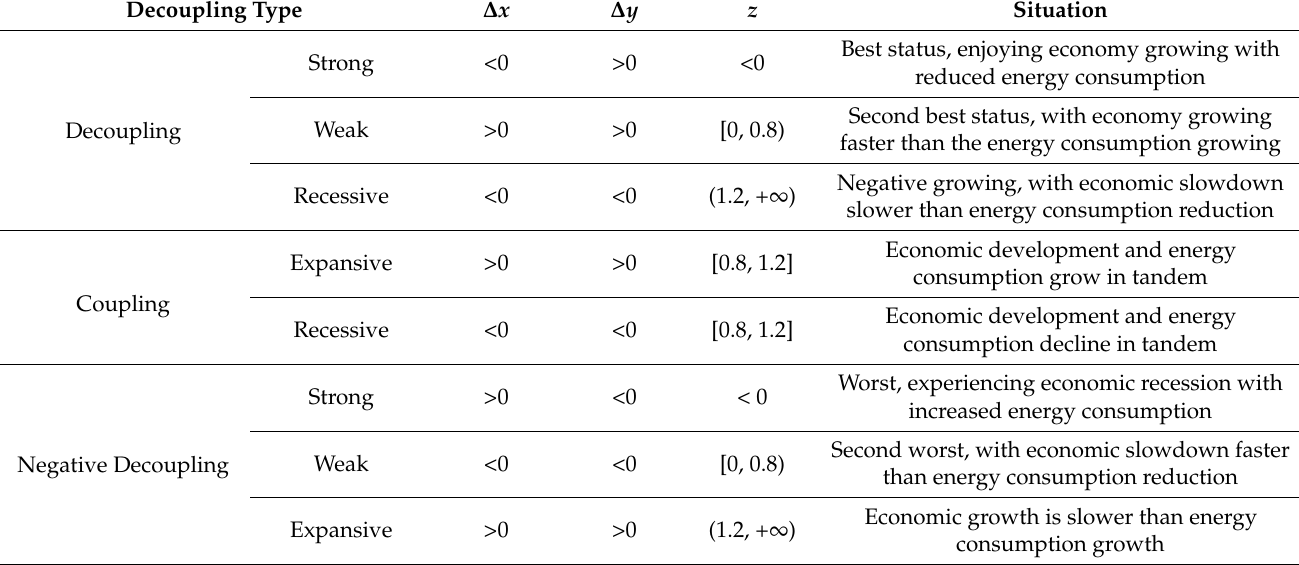
Table 1. Decoupling types and indicator